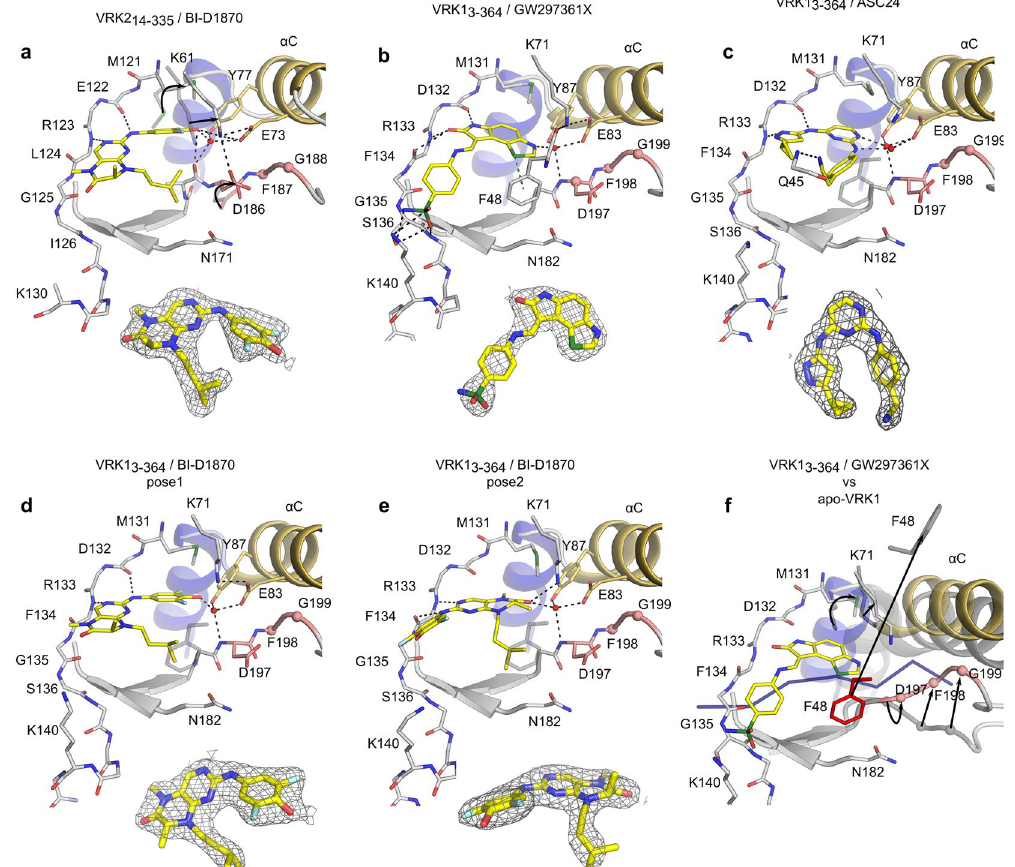
Figure 5. Crystallographic details of ligand binding. ( a ) Interactions between VRK2 14-335 and BI-D1870. Arrows indicate re-arrangements of key residues compared to apo-VRK2 (PDB:2V62). ( b ) Interaction between VRK1 3-364 and GW297361X. The ligand sulfonamide group interacts with residues Ser136 and Lys140 at the C-terminal end of the hinge region. A green dashed line indicates a sulfur- π interaction between protein and ligand. ( c ) Interaction between VRK1 3-364 and ASC24. The ligand acetonitrile group interacts with main chain amide from Gln45 in the protein P-loop. ( d , e ) Interaction between VRK1 3-364 and BI-D1870. The ligand can adopt two distinct poses in VRK1 ATP-binding site. Electron density maps of the ligands (2Fo-Fc, contoured at 1.0 σ ) are shown below each structural model. ( f ) Structural comparison of VRK1 ATP-binding site in complex with the regulatory C-terminal tail (NMR structure, PDB:2LAV, in faded gray; the backbone of the C-terminal peptide is shown in blue) and with GW297361X. Arrows indicate re-arrangements of key residues compared to the solution VRK1 NMR structure. Black dashed lines indicate potential hydrogen bonds. Red spheres indicate ordered water molecules. C α s of residues within the DYG motif are shown as spheres. In panels c–e, the position of Phe48 from VRK1 3-364 /GW297361X is shown for comparison (in faded gray). Color scheme as in Fig.